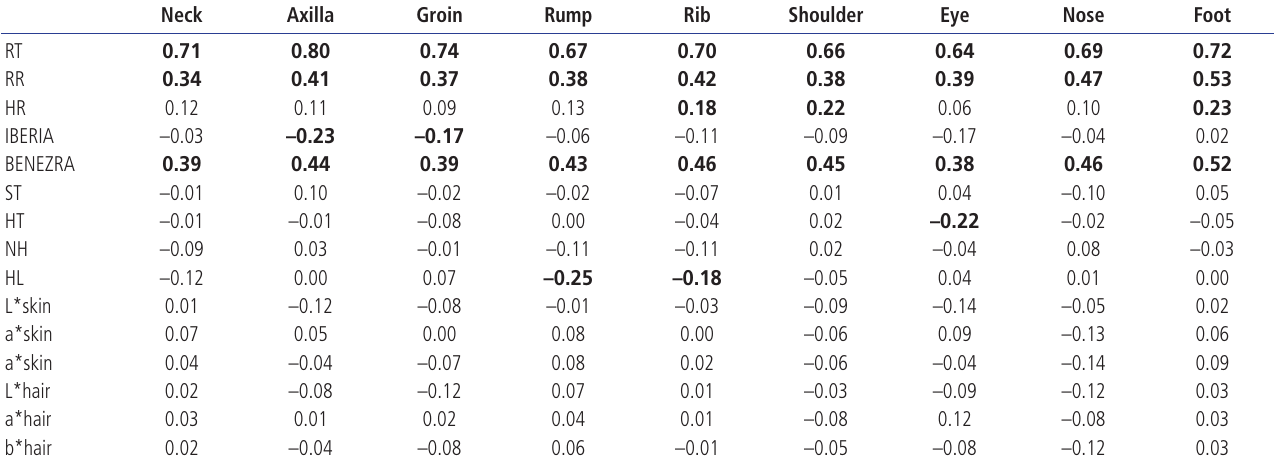
Table 7. Correlations between thermographic temperatures, physiological parameters, heat tolerance indices and physical characteristics 1) Neck Axilla Groin